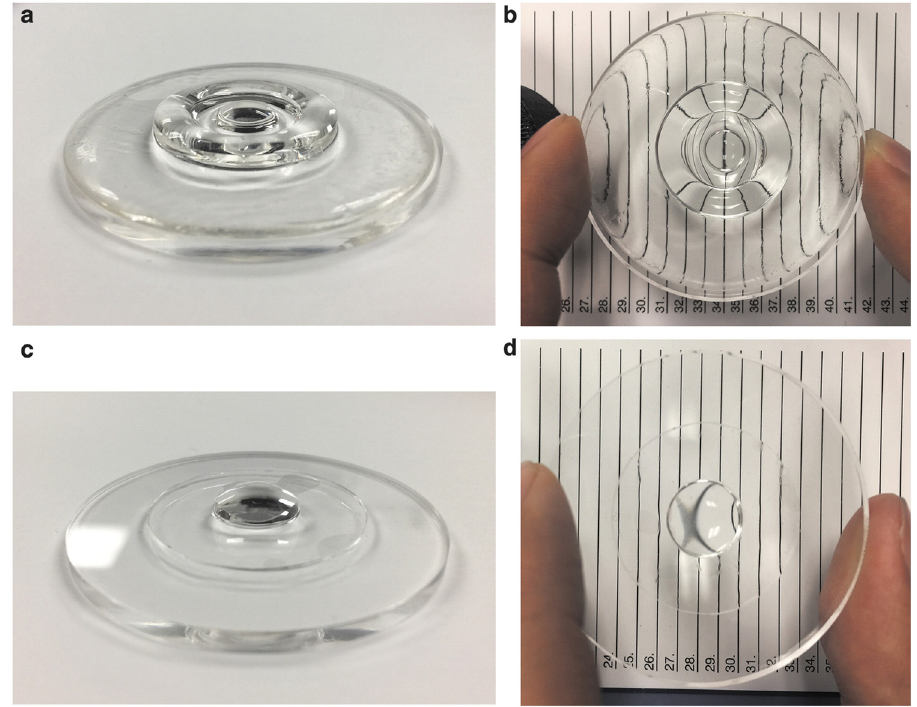
Figure 4: 3D - printed nonaxially symmetrical PDMS lens. ( a ) Donut shape lens, ( b ) donut shape lens showing ray bending, ( c ) nonaxially symmetry freeform lens, and ( d ) nonaxially symmetry freeform lens showing ray bending. From ref. ( 77 ) , originally published under a CC